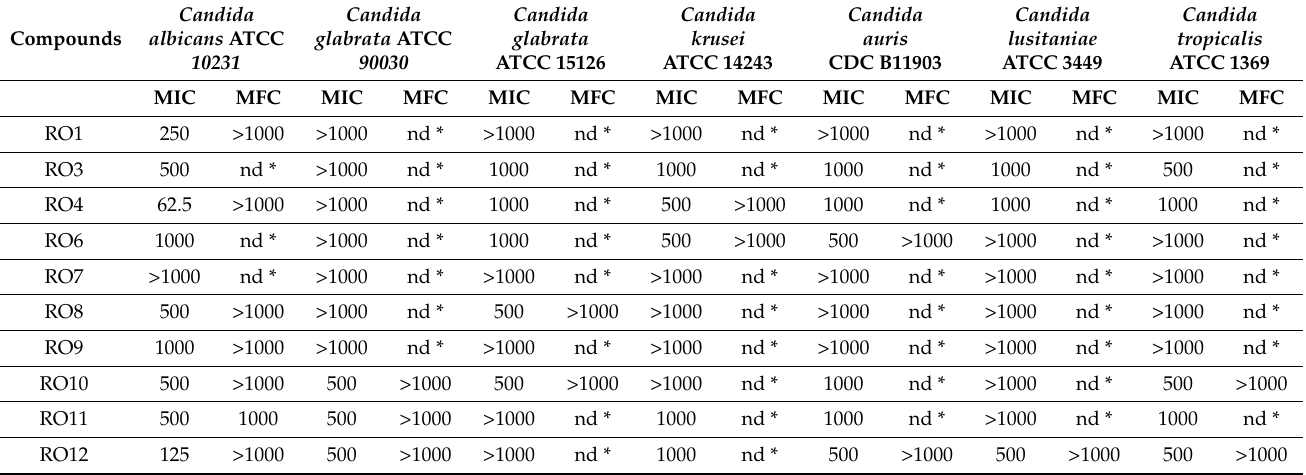
Table 2. Activity of the newly synthesized Schiff bases against reference strains of yeasts expressed as the values of the minimal inhibitory concentration (MIC; µ g/mL) or minimal fungicidal concentration (MFC; µ